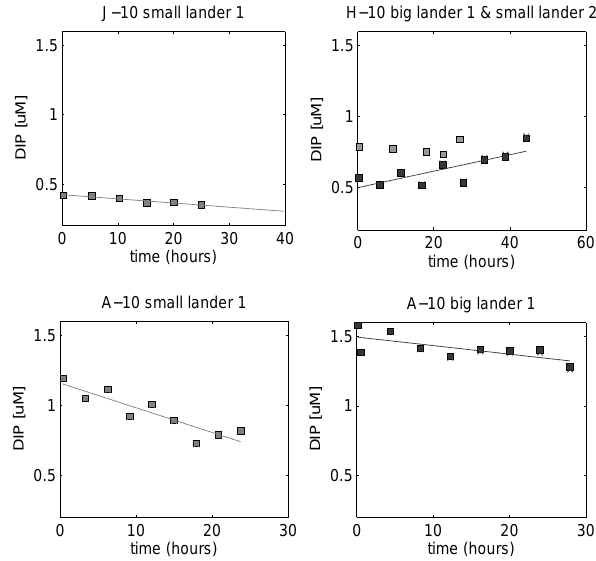
Fig. 5. Examples of evolution of the DIP concentration with time in chambers from oxic stations (J, H, A) on the 2010 cruise. The different shades of grey indicate different chambers. Filled squares indicate data points used to evaluate the flux. A full thin line means that the slope of the linear regression was used to calculate the flux (p < 0.05). No line indicates that the increase over time in the chamber was too small to be measurable and the flux was set to zero (the procedure to evaluate chamber data and to calculate fluxes is described in the text).